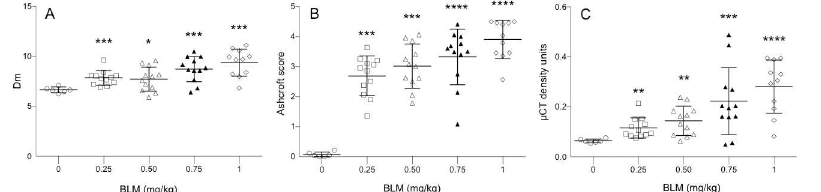
Fig 2. Bleomycin (BLM) administration resulted in elevatedlung tissue density and fibrotic Ashcroft scoring. 14 days after intratracheal BLM administration at doses of 0.25, 0.5, 0.75 and 1.0 mg/kg lung tissue alterations was assessedon the same wholelung slicesstained with Masson trichromeby automatichisto- logicalanalysis(A) and Ashcroft scoring(B) and in vivo in the same animalsby means of micro-CT analysis (C). BLM-treated mice (n = 12/dosinggroup)were comparedto salinecontrol mice (n = 6). Data are shown as mean ± s.e.m. The mean tissue density(Dm) determined by automatic histologicalanalysis(A) was